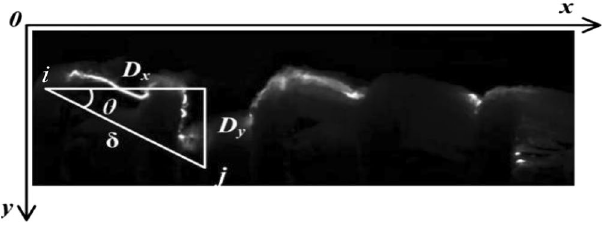
Figure 5. Calculation example of GLCM of surface discharge image along an ice-covered insulator